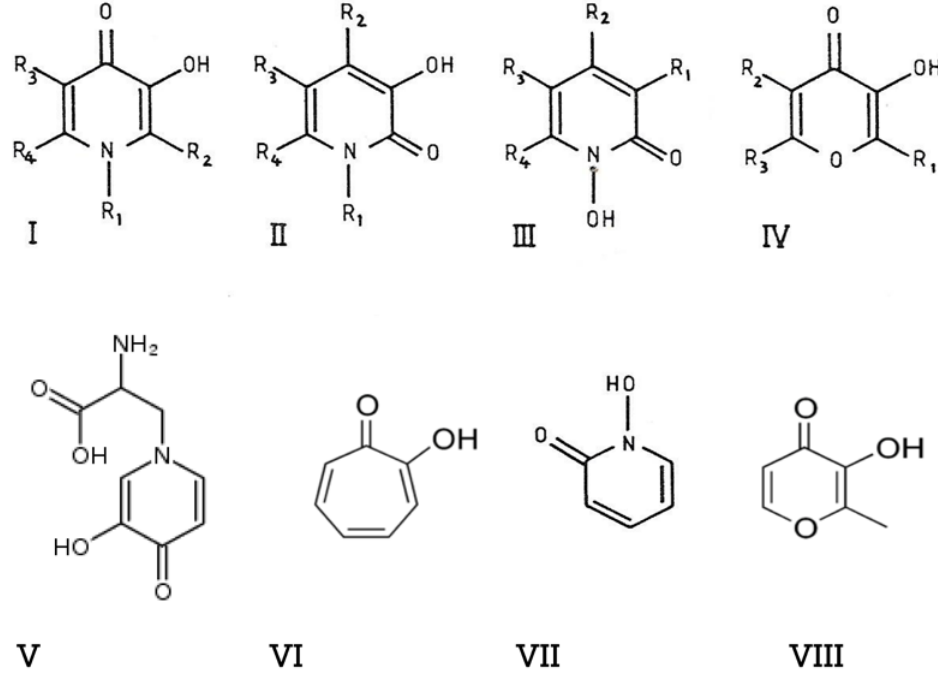
Figure 1. The design of the alpha-ketohydroxypyridine and alpha-ketohydroxypyrone iron chelators for clinical use. The chemical structures of four classes of iron chelators, namely 3-hydroxypyrid-4-ones ( I ), 3-hydroxypyrid-2-ones ( II ), 1-hydroxypyrid-2-ones ( III ) and 3-hydroxypyr-4-ones ( IV ), were identified 40 years ago, following a structure–activity simulation based on the prototype structures of the known compounds mimosine ( V ), tropolone ( VI ), 1-hydroxypyrid-2-one ( VII ) and maltol ( VIII ). Chemical synthesis and iron binding studies led to the development of the drugs deferiprone (L1) and maltol–iron for the treatment of iron overload and iron deficiency anemia, respectively (see [60]). Based on these prototype structures of alpha-ketohydroxypyrone and